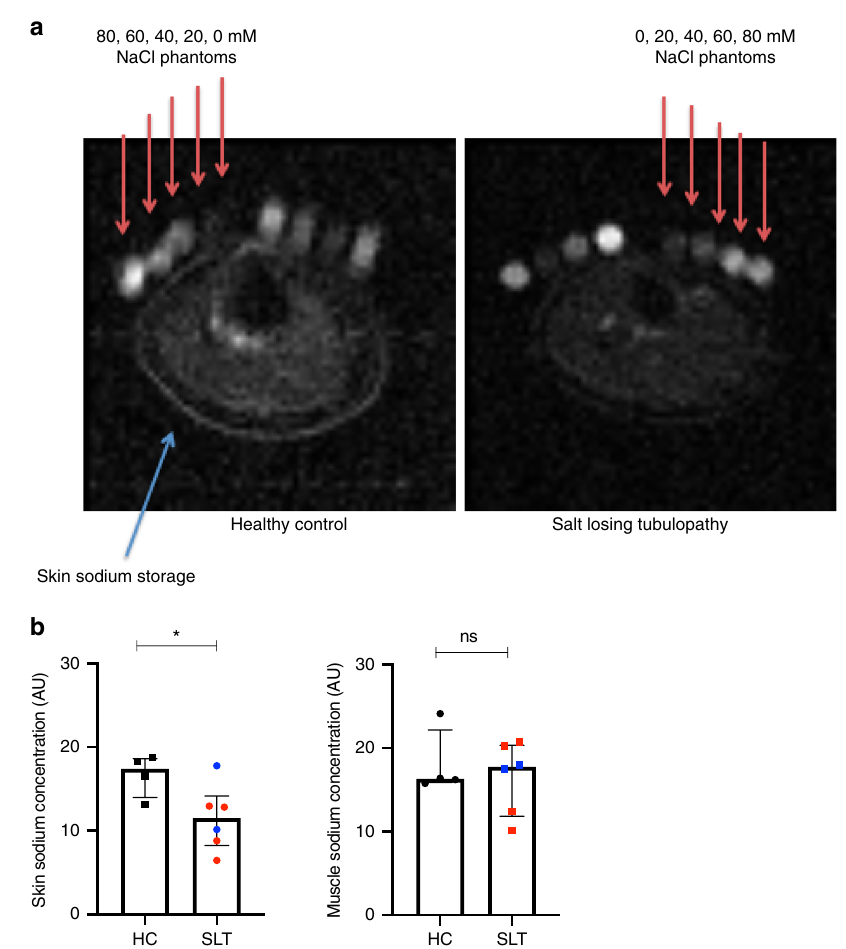
Fig. 1 23 Na MRI demonstrating reduced skin sodium stores in salt-losing tubulopathy patients compared to age-matched healthy controls. a Representative 23 Na MRI images of the lower limb from a SLT patient (Gitelman syndrome) and a HC. Phantoms of known sodium concentration (0 – 80 mM) are imaged alongside the lower limb (red arrows). b Skin and muscle sodium concentrations as determined by 23 Na MRI in SLT patients (GS = 4, red dots; BS type 1 = 2, blue dots) and age-matched healthy controls ( n = 4). Skin sodium: HC 17.4 (14.0 – 18.6) AU, SLT 11.5 (8.2 – 14.1) AU, p = 0.038; muscle sodium: HC 16.3 (15.9 – 22.1) AU, SLT 17.7 (11.8 – 20.3) AU, p = 0.99. Groups are compared with a two-sided Mann – Whitney test. Error bars